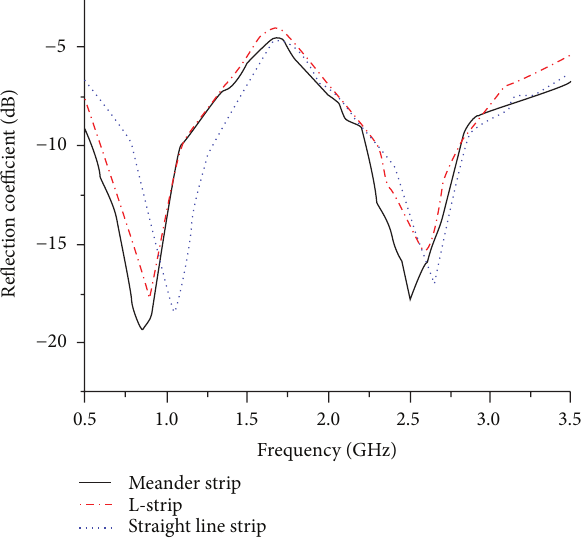
Figure 2: Simulated reflection coefficient for different numbers of slots inside radiating element.